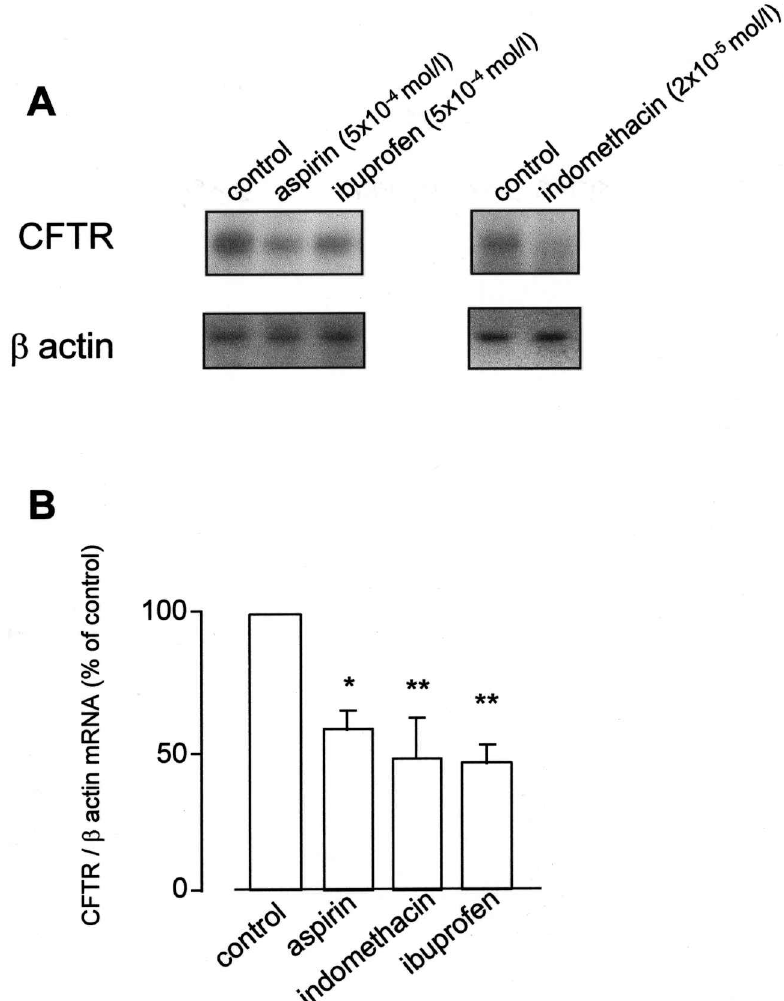
FIG. 3. Effects of aspirin, indomethacin, and ibuprofen on CFTR mRNA content in T-84 cells. (A) Representative Northern blot performed with 15 m g total RNA extracted from cells treated for 24h with the indicated concentrations (mol/l) of NSAIDs. (B) Amounts of CFTR transcripts normalized to those of b -actin mRNA. Each value is the mean±SE of four experiments. * P <0.05; ** P <